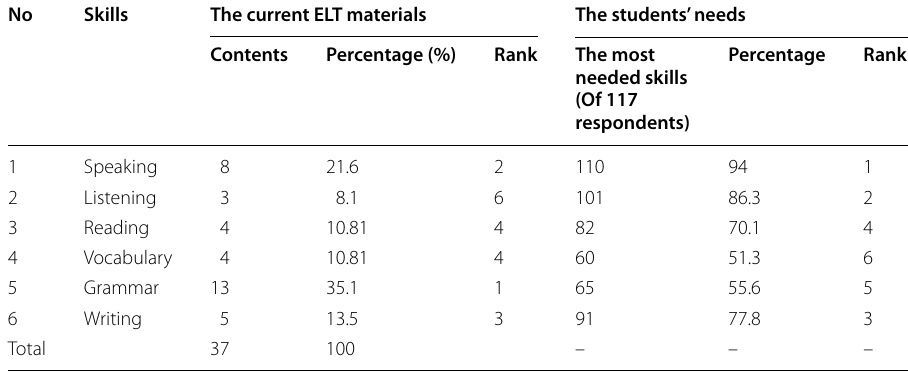
Table 4 The learners’ needs vs the contents of the materials No